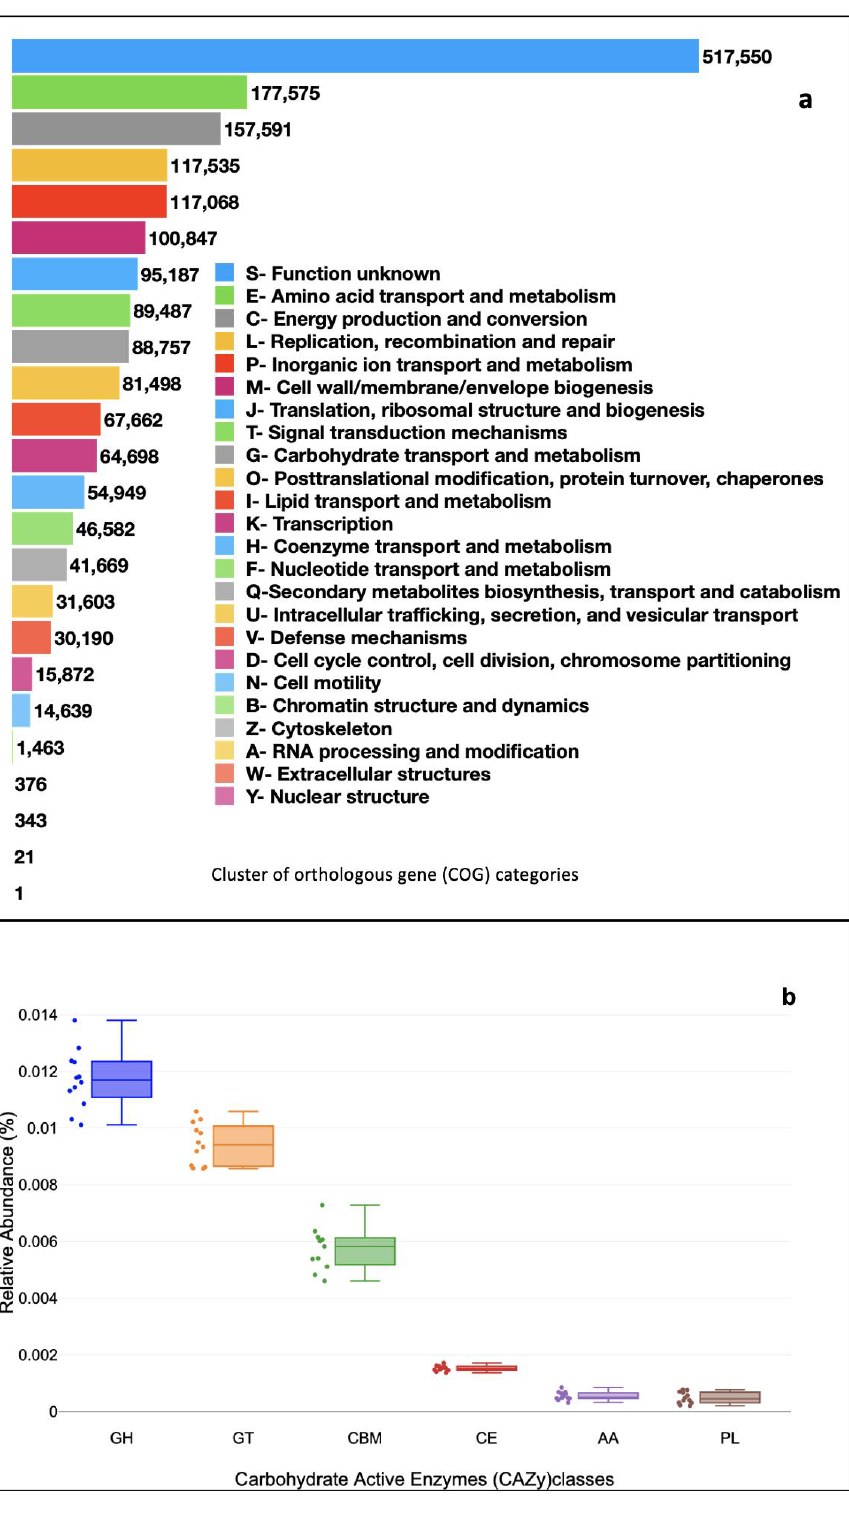
Figure 4. ( a ) Abundance of cluster of orthologous gene (COG) categories filtered through eggNOG database. ( b ) Level 1 carbohydrate-active enzyme classes filtered through (CAZy) database. y -axis shows the relative abundances (%), and the corresponding gene categories are plotted on the x -axis. For each gene category, a box and whisker plot is drawn. Boxes represent the interquartile range (25–75%), upper and lower whiskers − 10–90%; dashed black lines are median abundances. Dots are the abundance.